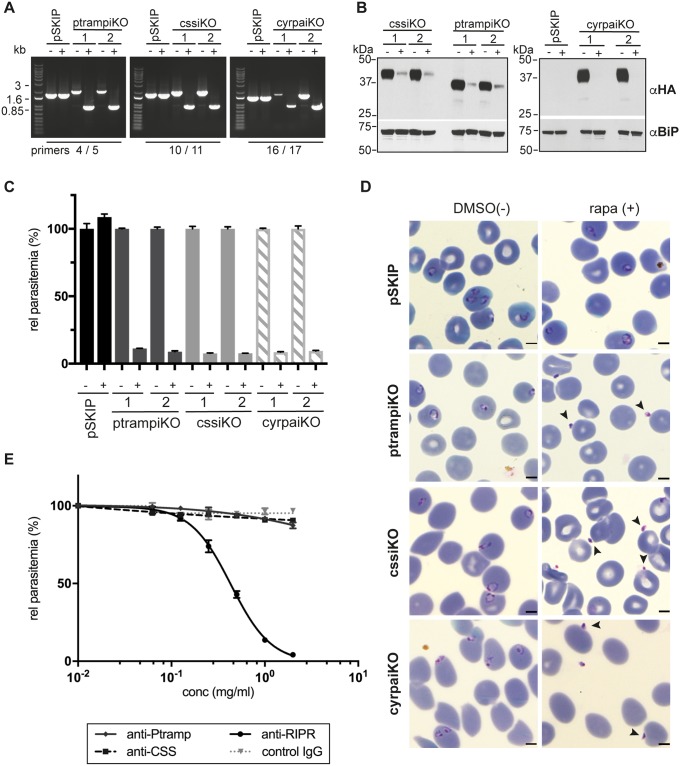
Newly identified complex components PkRIPR, PkCSS and PkPTRAMP are essential for human erythrocyte invasion, as is PkCyRPA.Inducible knockouts of pkcss, pkptramp and pkcyrpa were produced in the P. knowlesi DiCre expressing PkpSKIP 9–10 parasite line using CRISP/Cas9 gene editing. (A) PCR screen of wild type (pSKIP) and two clones of each transgenic parasite line (ptrampiKO, cssiKO, cyrpaiKO) showing successful and complete recombination of floxed gene sequences after rapamycin addition (+). Primer pair 4/5 specific for the ptramp locus amplified a 1741 bp band in wild type parasites, a 1993 bp band in mock -treated (-), transgenic parasites and a reduced size band of 965 bp after excision induced by rapamycin (+). Primer pair 10/11 specific for the css locus amplified a 1761 bp band in wild type, a 2013 bp band in mock-treated, transgenic parasites and a 919 bp band after excision. Primer pair 16/17 specific for the cyrpa locus amplified a 1467 bp band in wild type, a 1559 bp band in mock-treated and a 891 bp band in rapamycin-treated, transgenic cyrpaiKO parasites. DNA marker sizes are shown on the left. (B) Immunoblot of schizonts purified 26 h after DMSO (-) or rapamycin (+) treatment of ring stage cultures from wild type (pSKIP) and inducible knockout parasite lines. Two clones are shown for each knockout parasite. Blots were probed with anti-HA and anti-BiP antibodies as indicated on the right of the panels. All protein signals correspond approximately with their predicted molecular masses (HA-tagged PkCSS has a predicted molecular mass of 40.6 kDa, HA-tagged PkPTRAMP a predicted molecular mass of 39.2 kDa and PkCyRPA-HA a predicted mass of 42.5 kDa). Molecular mass standards are indicated on the left. (C) Invasion assay of wild type and inducible knockout parasites lines over one growth cycle. Parasitemias were measured by flow cytometry 40 h after rapamycin / DMSO treatment. Means and standard errors of three independent experiments carried out in triplicate are displayed. (D) Giemsa-stained brightfield images of wild type and inducible knockout parasites 30 h after DMSO (-) or rapamycin (+) treatment. Arrowheads point to merozoites attached to erythrocytes which have failed to invade. Scale bars equal 2 μm. (E) Growth inhibition assay of PkA1-H.1 parasites over one cycle with serial dilutions of purified IgG raised against recombinantly produced PkPTRAMP, PkCSS, PkRIPR or control rabbit IgG. Parasitemias were determined by flow cytometry 18 h after assay setup at schizont stage. Means and standard errors of three independent experiments in triplicate are displayed.